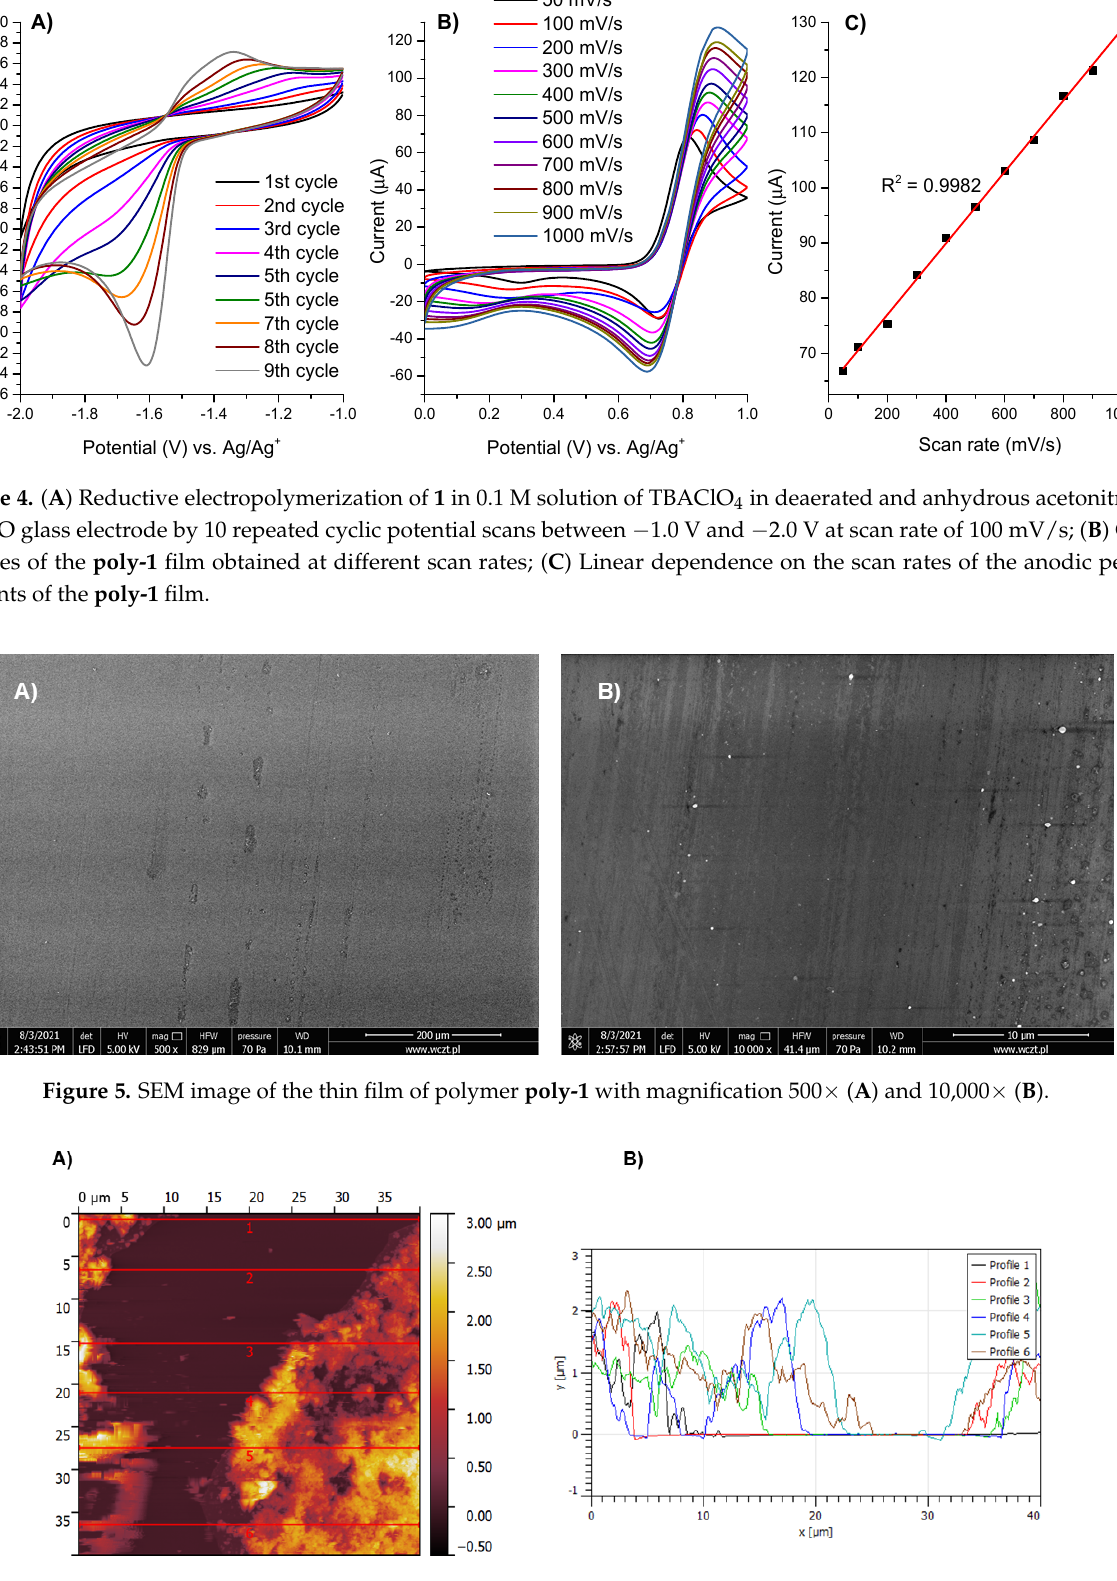
Figure 6. ( A ) AFM micrographs of poly-1 at a 40 μ m × 40 μ m resolution scale deposited on ITO electrodes showing the step between the ITO and the polymer surface. ( B ) AFM cross-section profiles measured at a marked places. The film was found to have the average thickness of ~1.5 μ m. Root mean square (RMS) roughness parameter measured by atomic force microscopy (AFM) was calculated to be 153 nm.